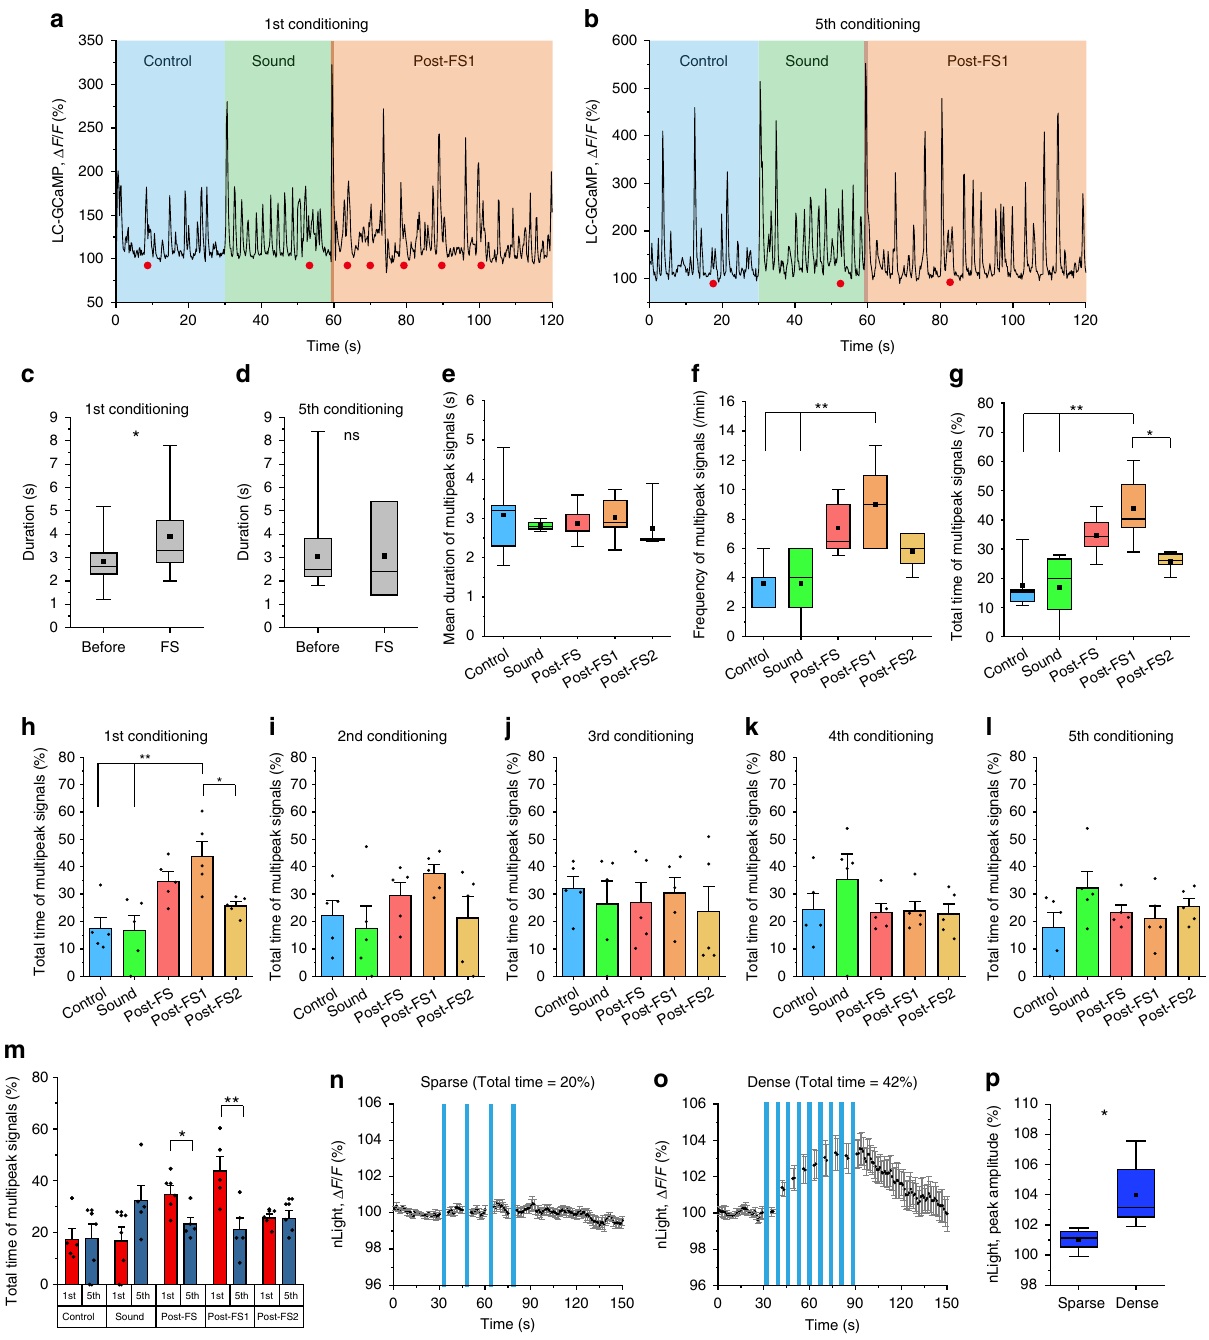
Fig. 7 Head- fi xed fear conditioning increases NAergic multipeak signals in 1st conditioning. a , b Sample traces of NAergic fi bers ’ Ca 2 + activity in